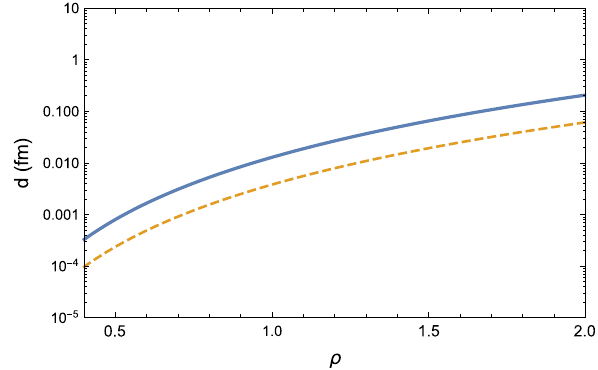
Fig. 8 We plot the stiffness distance of monopolium as a function of the size parameter for two values of the monopole mass